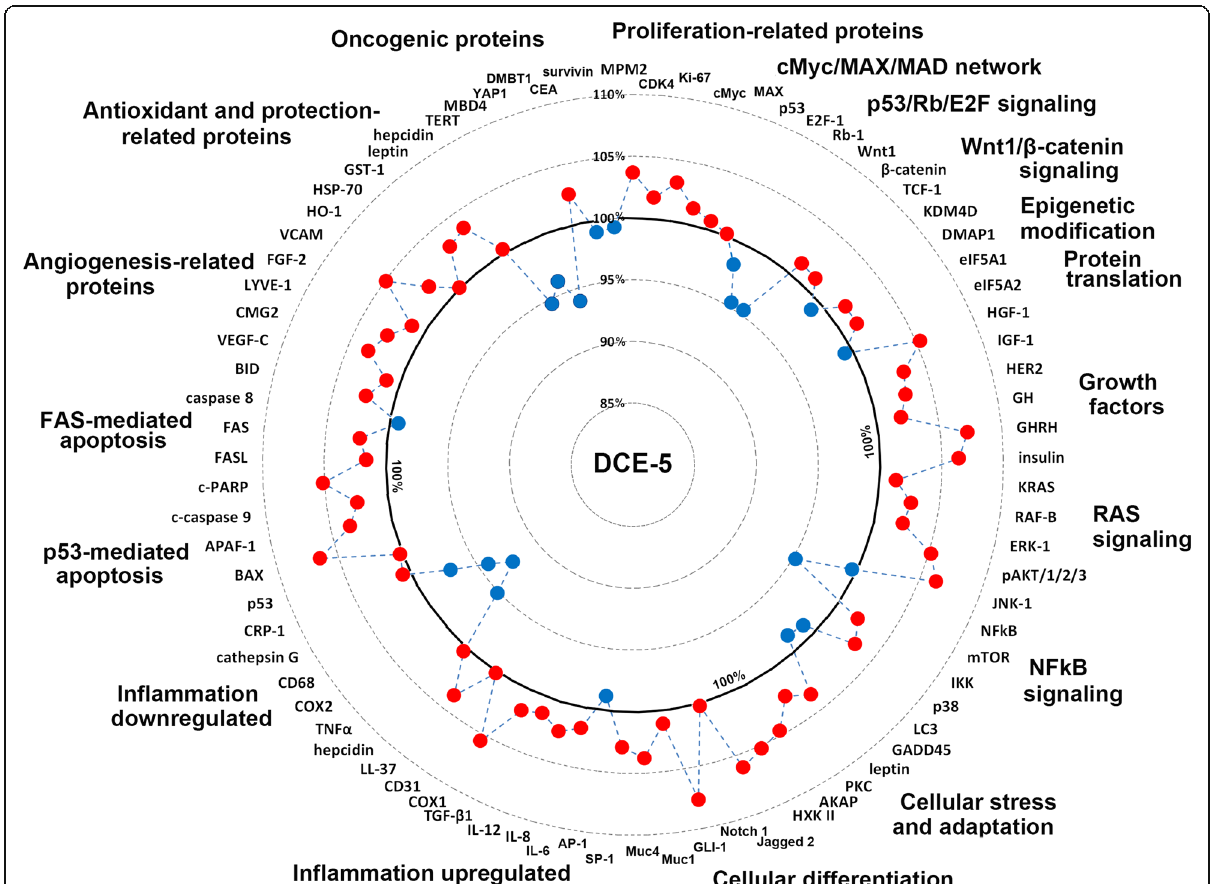
Fig. 8 Global protein expression diagrams showing the effects of DCE-5 in mouse liver. Mouse livers treated with DCE-5 showed characteristic patterns of molecular signaling for up- (red round circles) and downregulating (blue round circles) essential proteins for cellular proliferation, protection, adaptation, differentiation, apoptosis, and